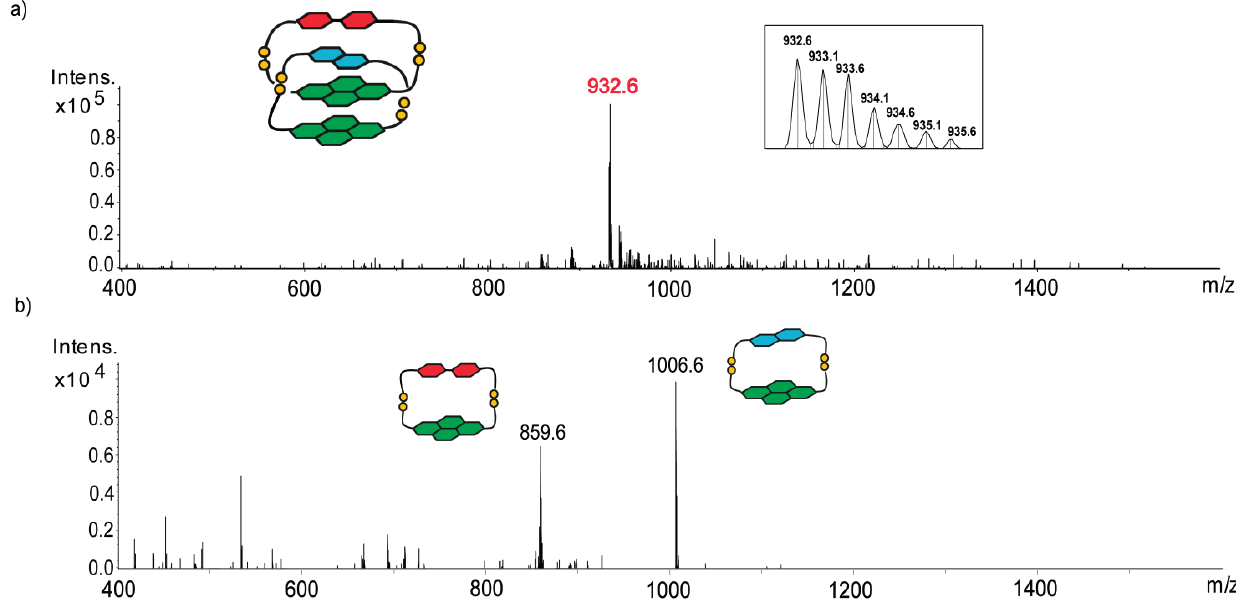
Figure 4. ( a ) ESI-MS and ( b ) MS/MS fragmentation of the ADAA (A, acceptor; D, donor; Intens., Intensity) catenane (molecular ion highlighted in red). A fragmentation amplitude of 0.6 V was used. The orange dots represent the sulfur atoms of the cysteine residues in the disulfide